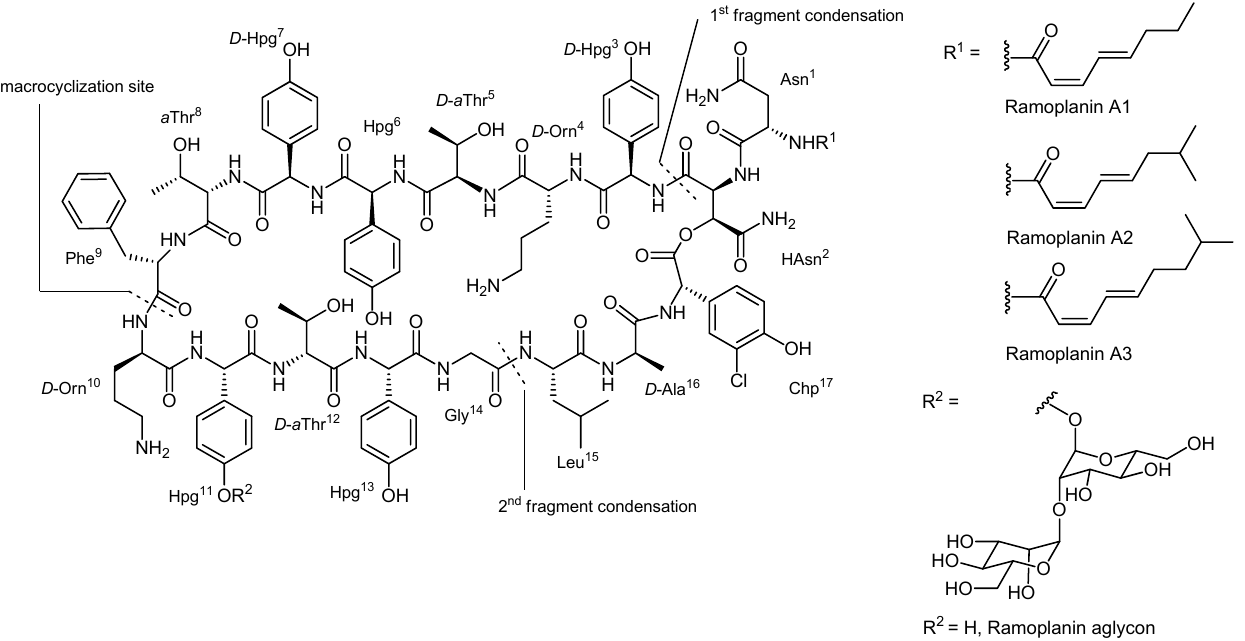
Figure 3. Fragmentation of Ramoplanin for a convergent synthesis approach